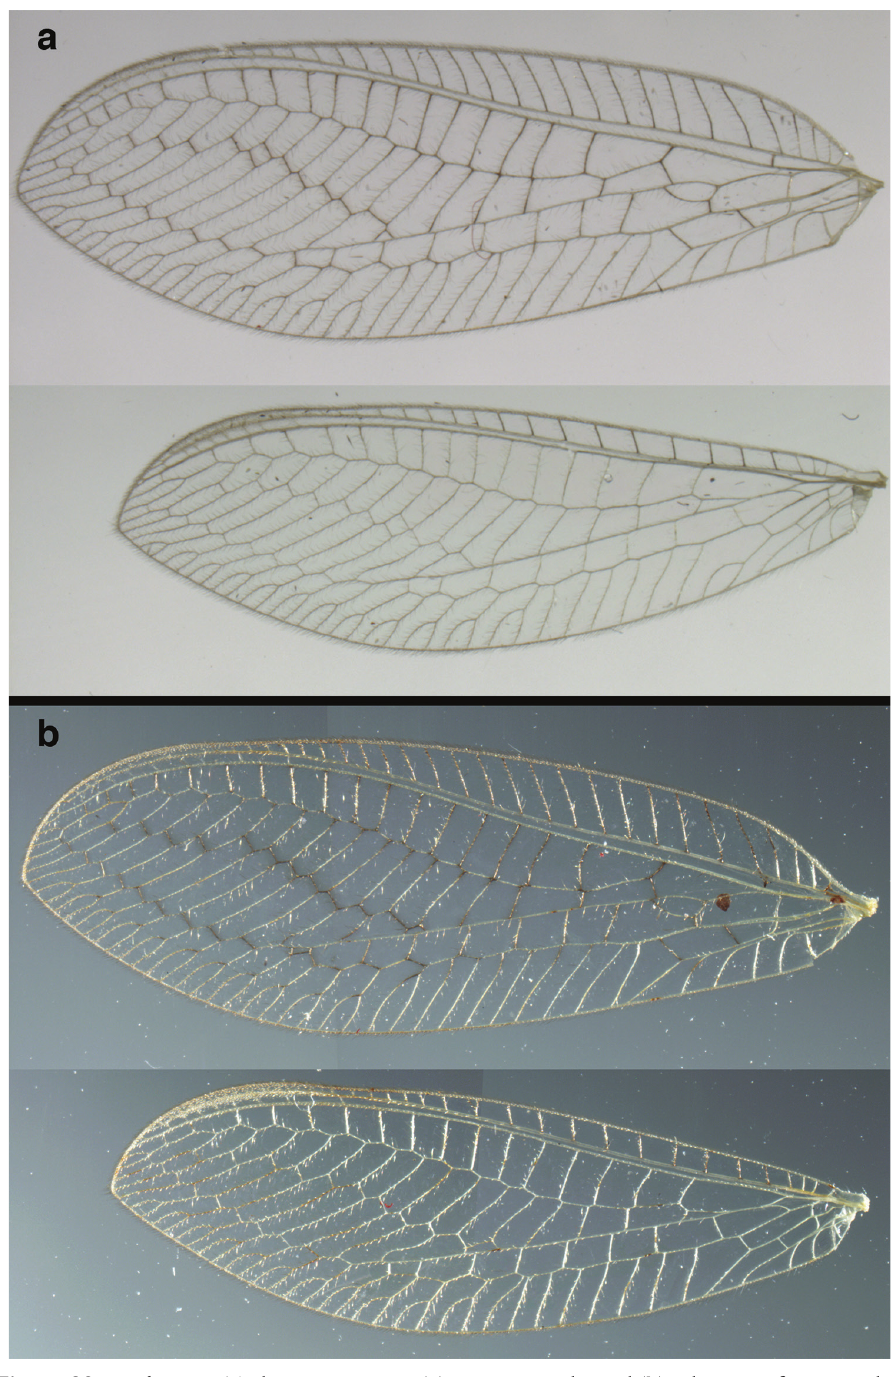
Figure 89. Ungla stangei Tauber, sp. n. Wings, ( a ) venation emphasized ( b ) coloration of veins empha- sized (Bolivia, La Paz, paratypes, male,